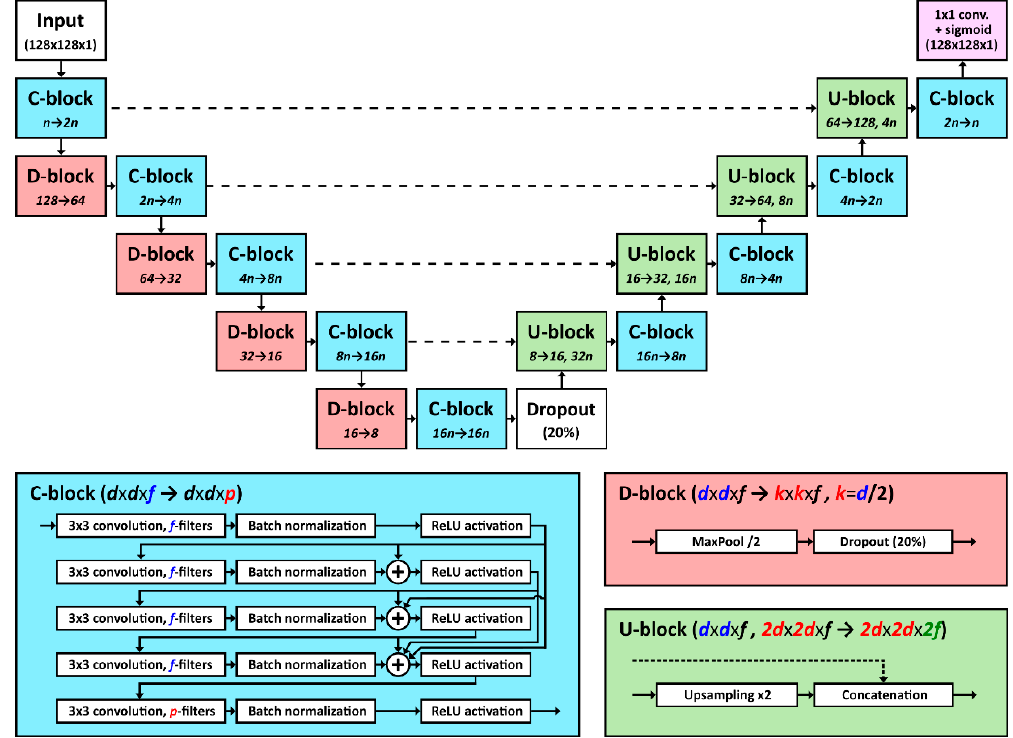
Figure 4. Overview of the architecture of the proposed convolutional neural network (CNN) for semantic segmentation of salt deposits. The network consists of three kinds of blocks (C, D, and U) that are showed in detail bellow. The final output is obtained by 1 × 1 convolution with 1 filter followed by the sigmoid activation function. The initial number of filters is indicated by n .